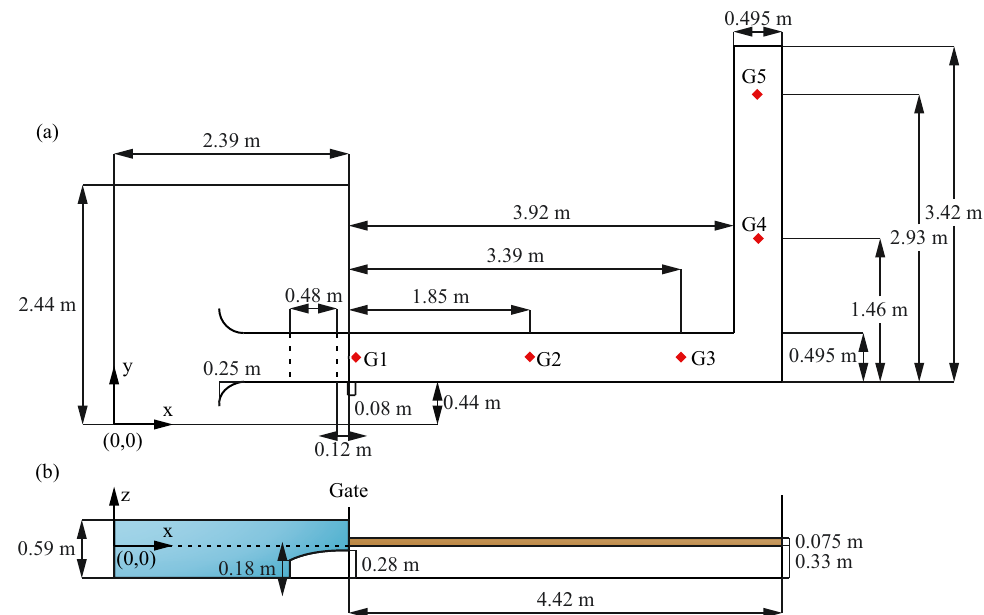
Figure 1. ( a ) Plane view of the experimental flume and position of the gauges G1 to G5; ( b ) vertical cut taken along the longitudinal axis of the first part of the